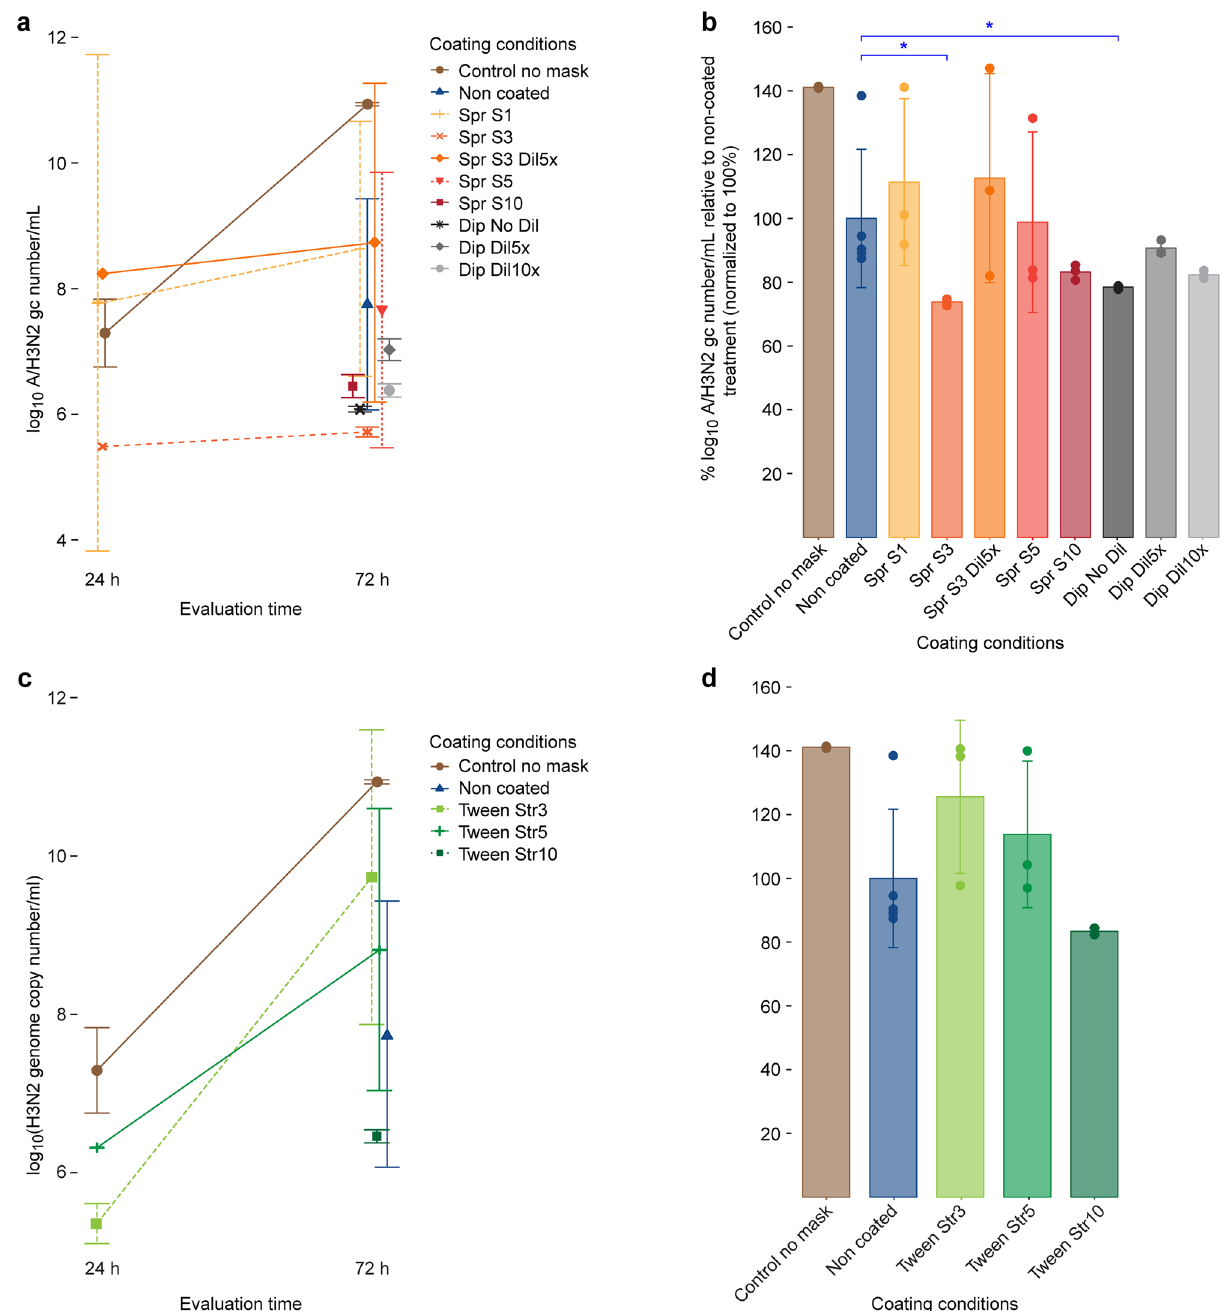
Figure 4. TAQMAN reverse transcription-polymerase chain reaction for the determination of A/H3N2 virus genome copy (gc) numbers in the apical medium of MUCILAIR epithelia infected after direct contact of the virus with a non-coated test material or a test material coated with various concentrations of salt or Tween. ( a ) Salt coatings, log 10 A/H3N2 gc number/mL quantified at 24 and 72 h post infection. ( b ) Salt coatings, viral replication at 72 h post infection. ( c ) Tween coatings, log 10 A/H3N2 gc number/mL quantified at 24 and 72 h post infection. ( d ) Tween coatings, viral replication at 72 h post infection. Data are expressed as a percentage relative to the mean of log 10 A/H3N2 virus gc number/mL quantified in the infected non-coated treatment group, which was normalized to 100%. Means ± standard errors are shown; n = 3 in all treatments, except for non-coated (n = 5). * P <